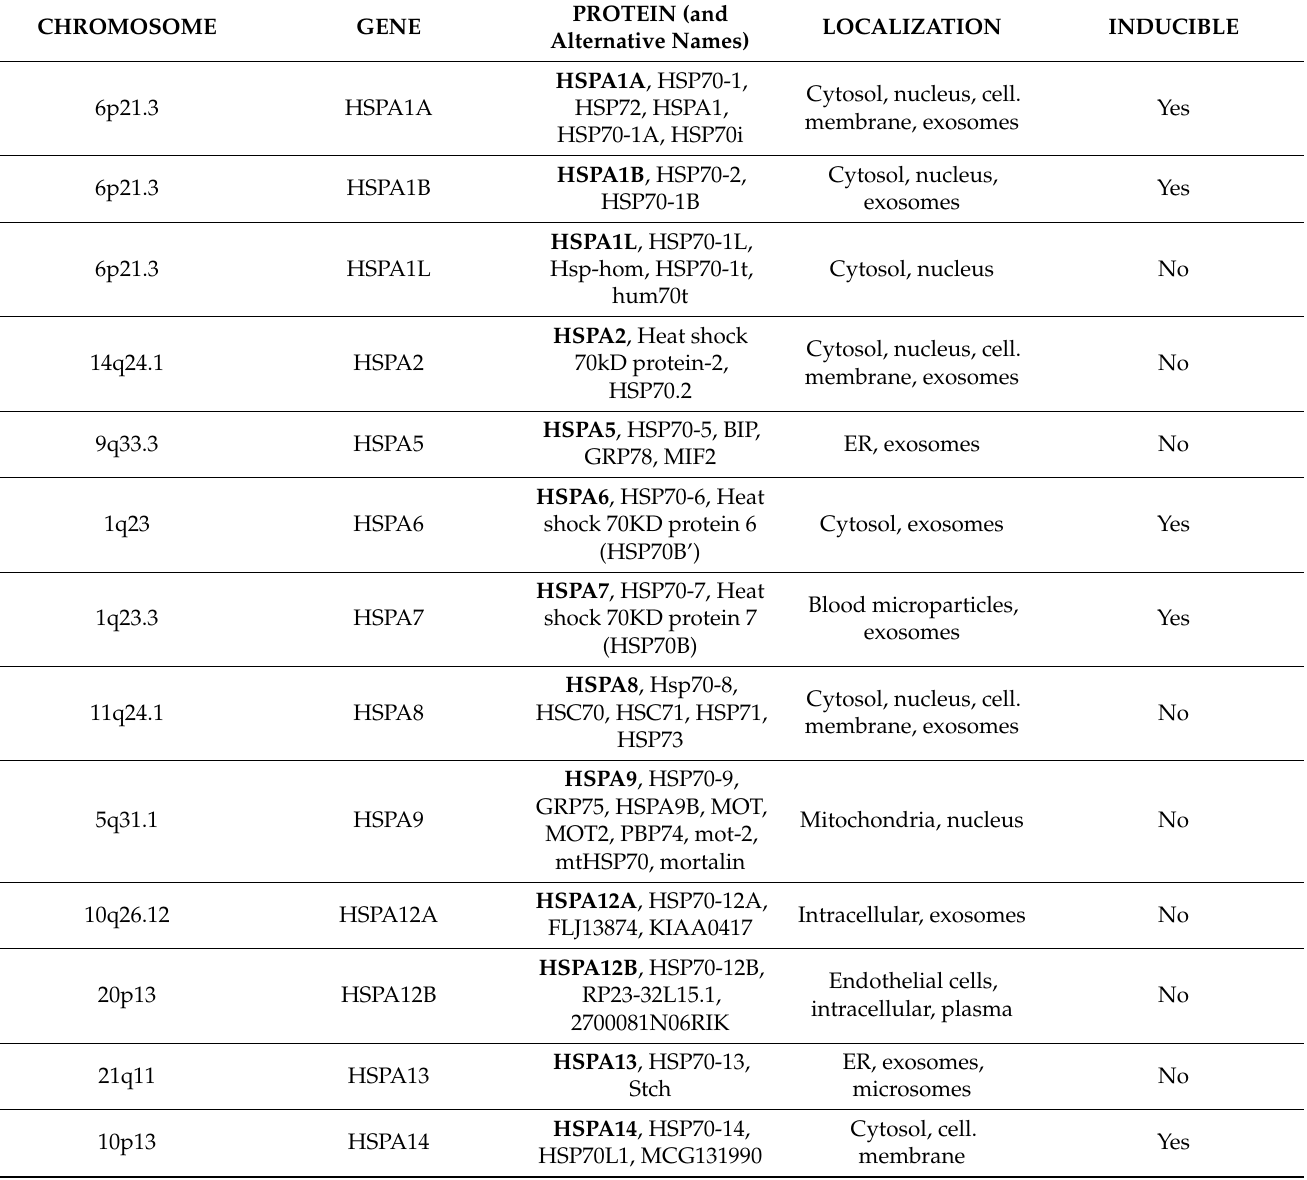
Table 1. HSP70 family